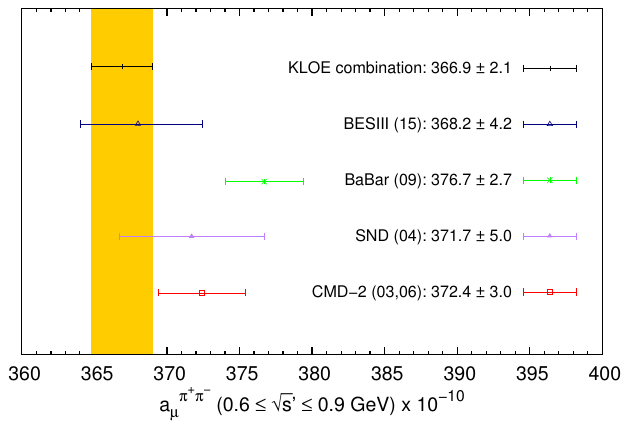
Figure 10. Estimates of a (cid:25) + (cid:25) (cid:0) from the KLOE combination, CMD-2, SND, BaBar and BESIII p (cid:22) in the range 0 : 6 < s 0 < 0 : 9 GeV. The available CMD-2 data have been combined following the prescription of [12]. The KLOE combination is represented by the yellow band (colour online). In all cases, the uncertainties shown are the statistical and systematic uncertainties summed in quadrature.